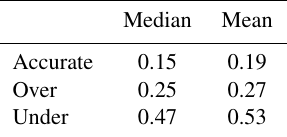
Figure 2. A histogram of area ratios for 28 floodplains shows a tendency for the NWM–HAND to underpredict flood extents. Table 2. Mean and median AOU statistics for the 28 floodplain stud-